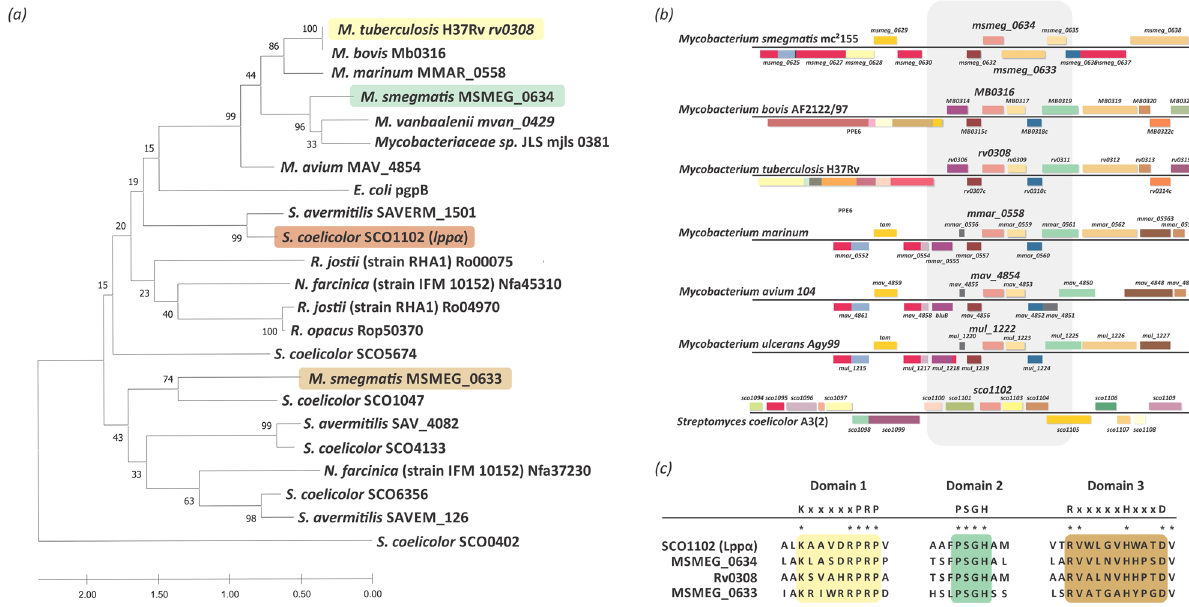
Figure 1. Bioinformatic analysis of PAPs. ( a ) Phylogenetic tree of PAP enzymes from different actinomycetes. The maximum likelihood phylogenetic tree was constructed using the MEGA X software. The bootstrap percentage supports (1000 replicates) are indicated in the different branches. ( b ) Comparative analysis of the genomic context of putative PAP enzymes from mycobacteria and Streptomyces coelicolor . ( c ) Sequence alignment of PAP2 domains. The key residues for this catalytic activity are